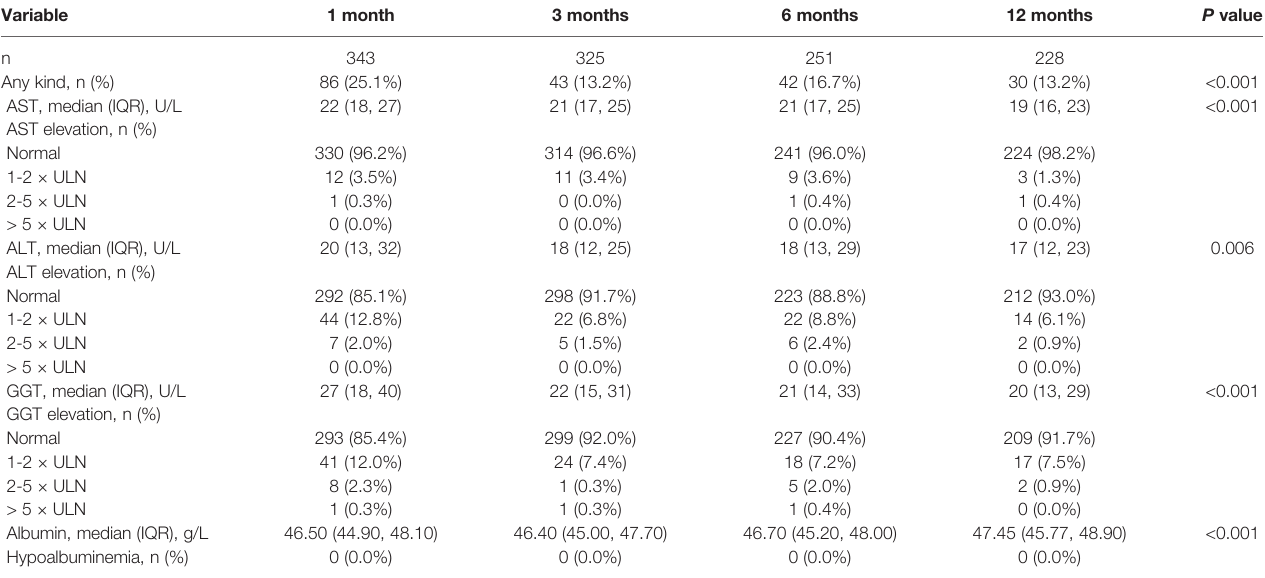
TABLE 2 | Liver Function Tests Abnormalities in Patients with COVID-19 at the Time of Follow-up. Variable